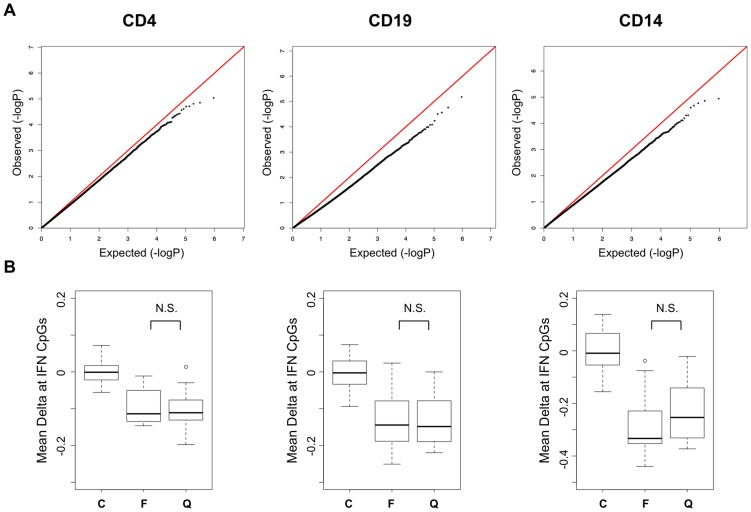
Disease activity QQ-Plots and the persistence of hypomethylation in quiescent patients.
A. QQ-Plots of the p-values from the flare versus quiescent association analysis for each cell type, illustrating the lack of activity-dependent DNA methylation. B. Boxplots of the methylation difference between each individual and the mean of all controls at CpGs in IFN-regulated genes among those that were highly significant in the SLE-control tests. The groups are labeled C, Control, F, SLE collected during a flare, and Q, SLE collected during quiescence.